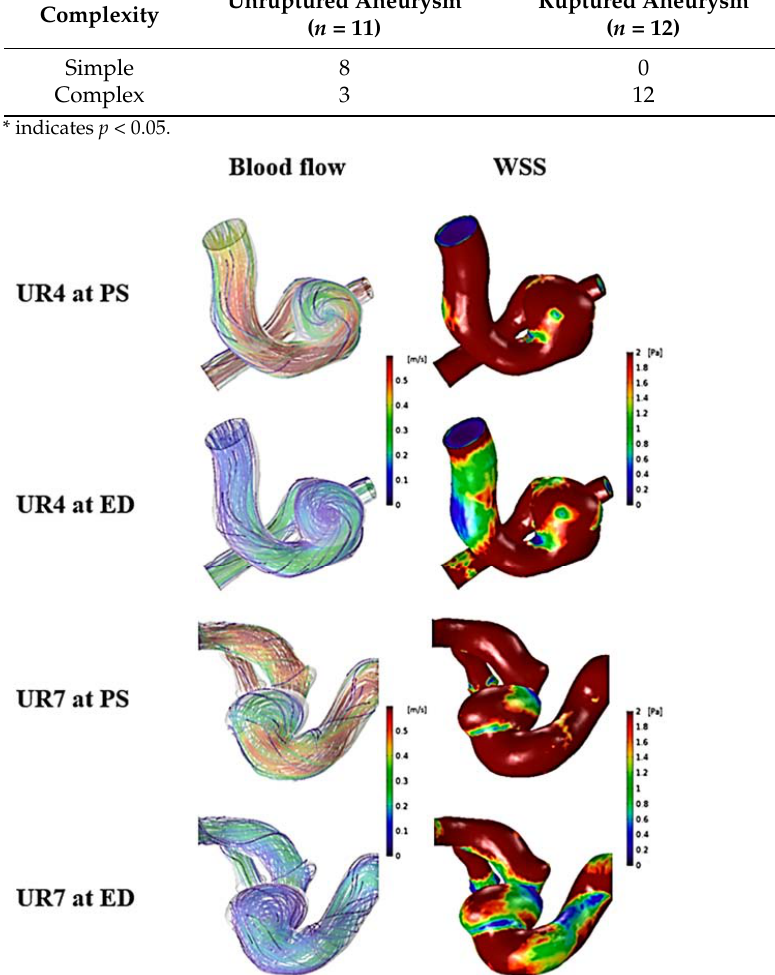
Figure 5. Two representative cases (UR4 and UR7) for unruptured aneurysms at peak ‐ systole and end ‐ diastole. The streamlines showing flow stability of the unruptured aneurysms (blood flow column). The distribution of wall shear stress on the aneurysm, showing low wall shear stress area (WSS column). PS: peak ‐ systole; ED: end ‐ diastole; UR: unruptured aneurysm; WSS: wall shear stress.